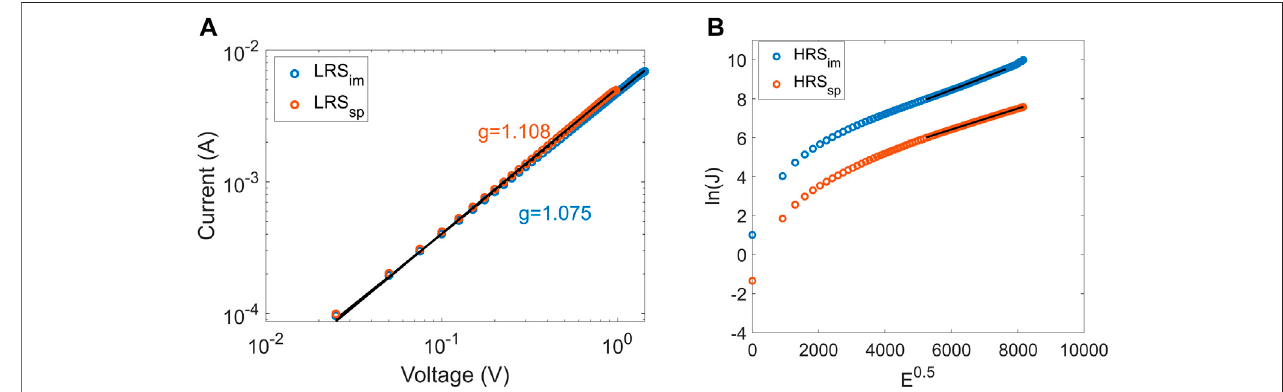
FIGURE 5 | (A) Fitting of LRS I-V curves in a log-log plot, LRSsp is the LRS from sputtered SiO x and LRSim is the LRS from implanted ALD-grown SiO x . (B) Thermionic emission fi tting of HRS I-V